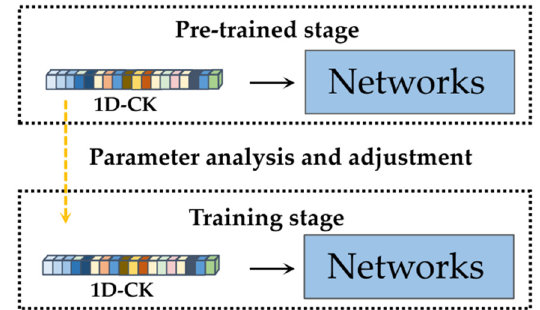
Figure 3. Adjustment strategy of TFCK.